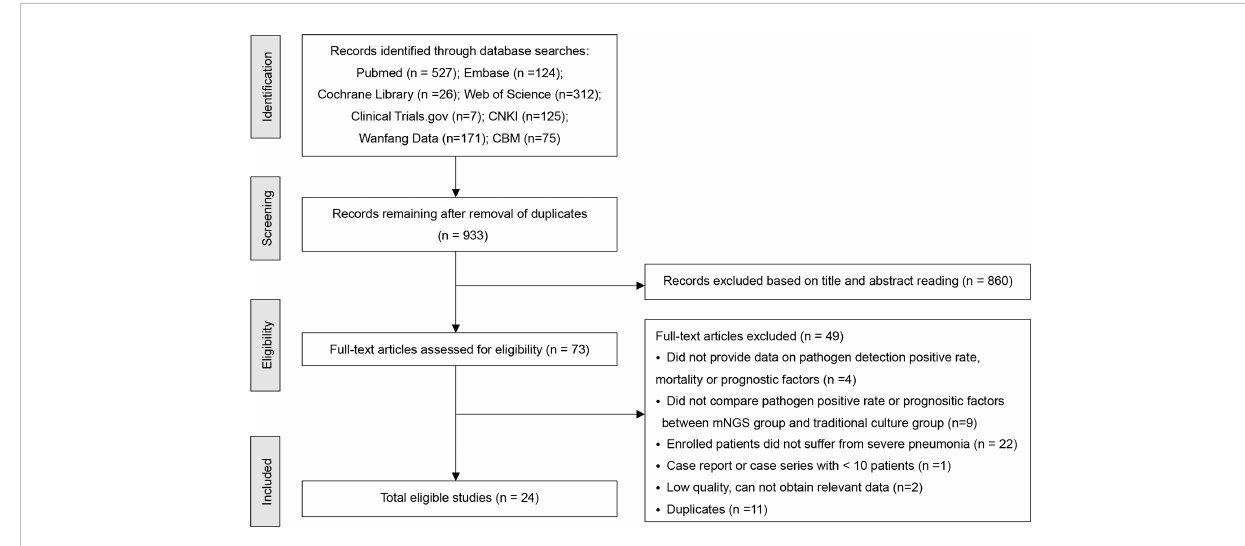
FIGURE 1 The fl ow diagram of included